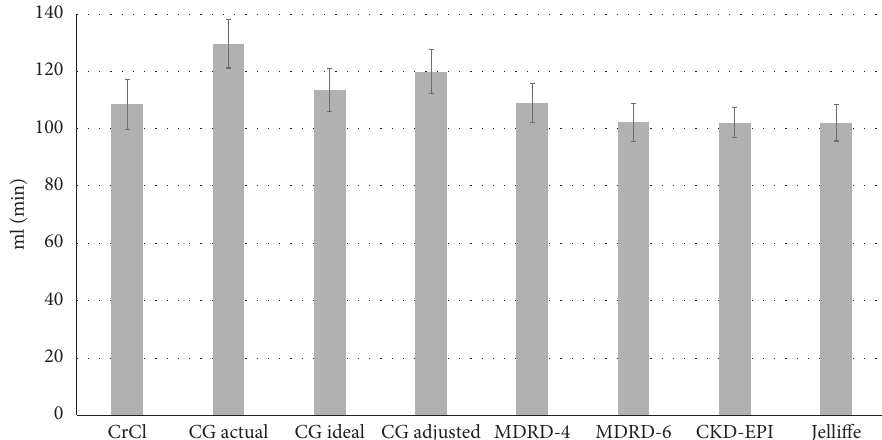
Figure 1: Mean values of the measured creatinine clearance by 24-hour urine collection (CrCl 24h-urine ) and estimated glomerular filtration rate by different equations. The first 237 24-hour urine samples were used in this analysis. Error bars represent 95% confidence interval. The difference between the different methods was significant ( p < 0 . 001) by ANOVA test. CG: Cockroft–Gault equation; MDRD-4: 4-variable modification of diet in renal disease equation; MDRD-6: 6-variable modification of diet in renal disease equation, and CKD-EPI: chronic kidney disease epidemiology collaboration